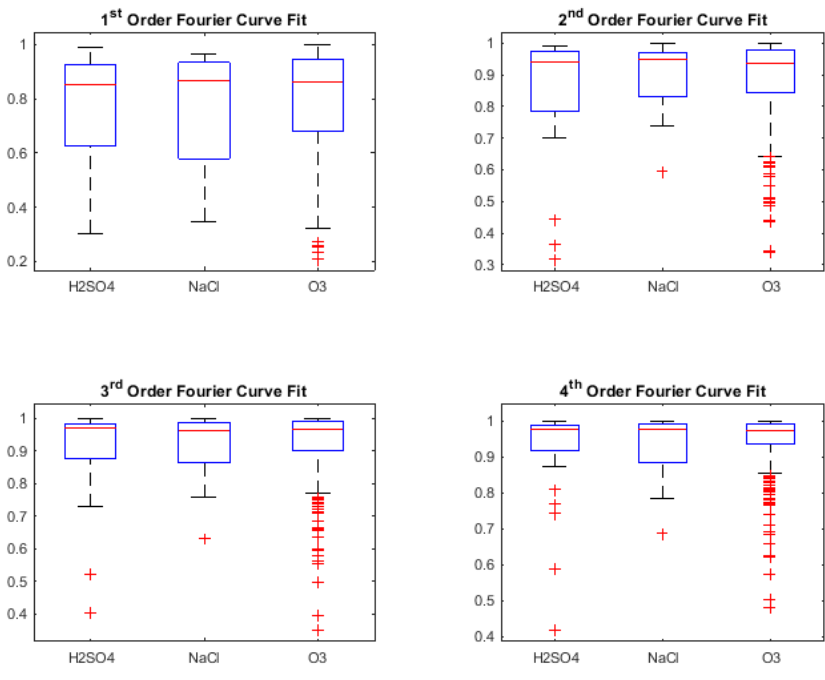
Figure 6. R-squared values for Fourier curve fitting.